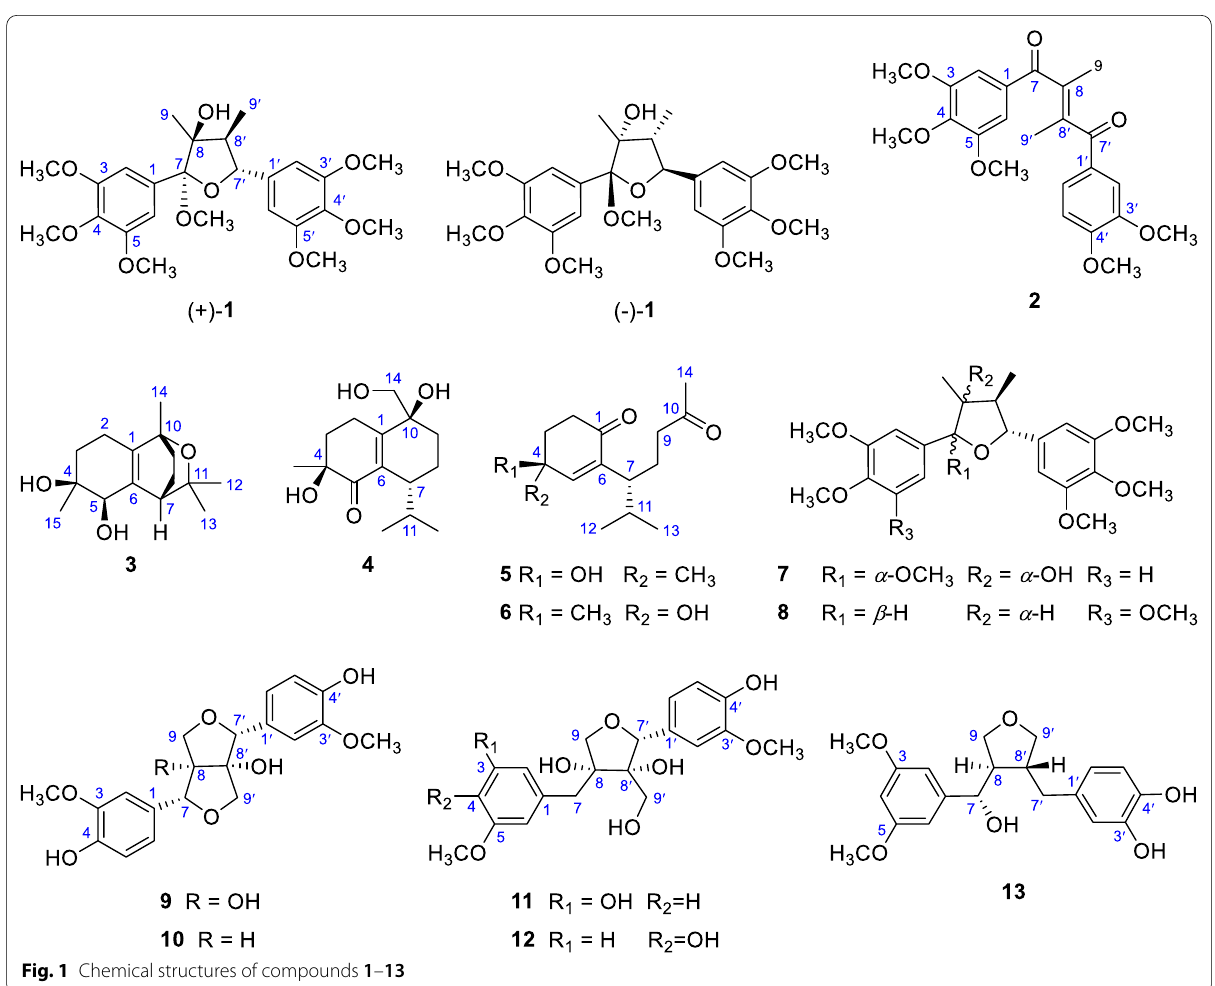
Fig. 1 Chemical structures of compounds 1 –